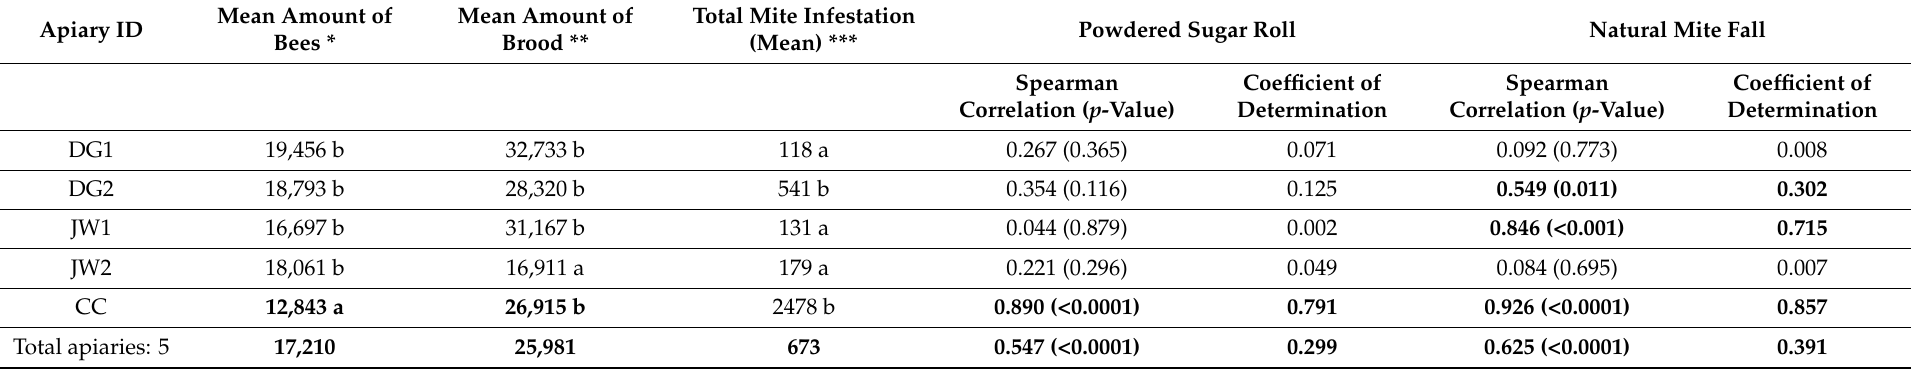
Table 4. Strength of colonies and total mite infestation in subsequent apiaries. Correlation between the number mites in colonies and the infestation of samples tested using different methods. Protocol